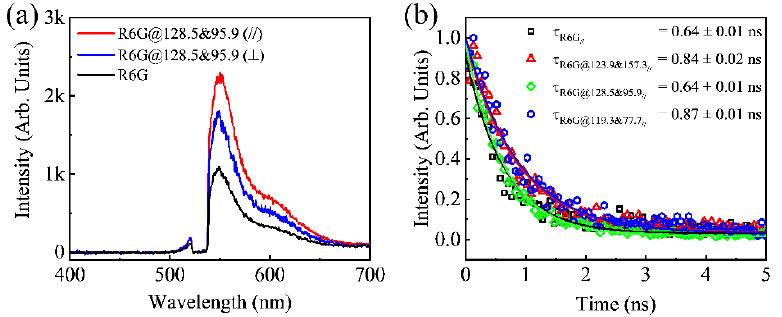
Figure 5. ( a ) Typical PL spectra of the R6G molecules with and without the silicon dimer under longitudinal and transverse excitation. ( b ) Decay curves of R6G@dimers under longitudinally polarized laser excitation. Table 1. Enhancement Factors of R6G@Dimers under Longitudinally and Transversely Polarized Laser Excitation.